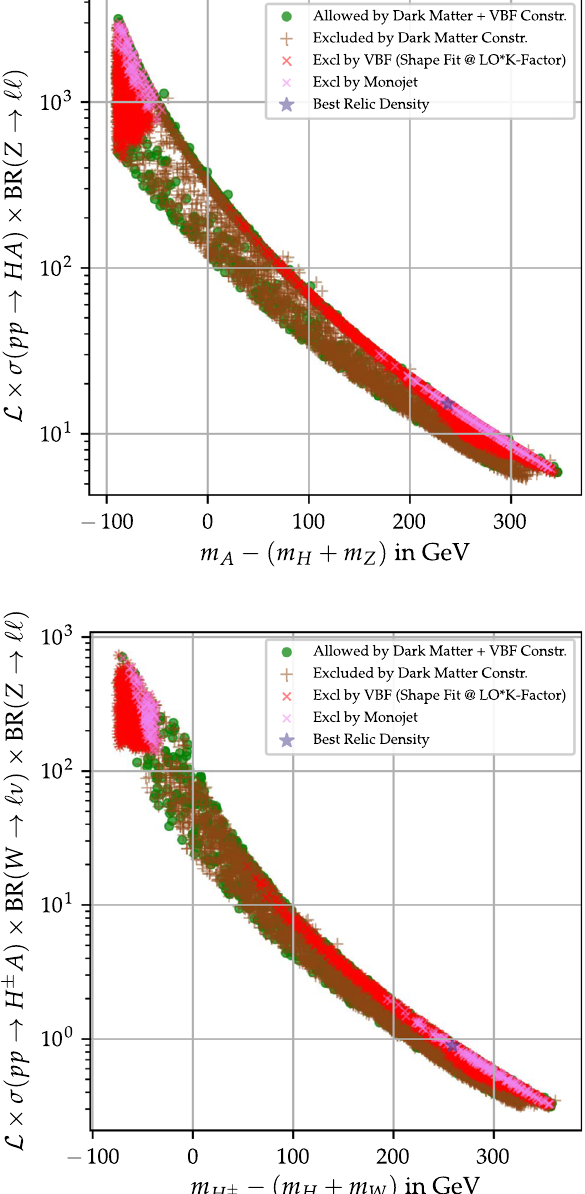
Fig. 7 Predicted number of events in the 2 (cid:14) /3 (cid:14) channels. The x -axis shows mass differences as in Fig. 6. The y -axis denotes the product of integrated luminosity, total production cross section and leptonic branching ratio of the expected gauge boson(s) in the final state the peak region of the direct search are neither excluded by the VBF channel nor by dark matter direct